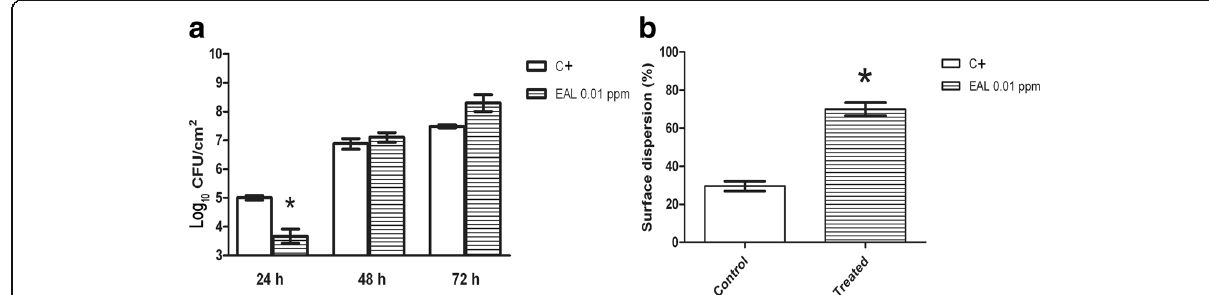
Fig. 7 CDC biofilm growth on polycarbonate coupons ( a ) and biofilm dispersion rate ( b ) of C. albicans in absence (positive control) and in presence (treated) of 0.01 ppm of Enhalus acoroides leaf extract. Stars indicate statistically significant differences (Tukey ’ s HSD, p ≤ 0.05) between the means of three independent replicates. (C + = Positive control; EAL = Enhalus acoroides leaf)